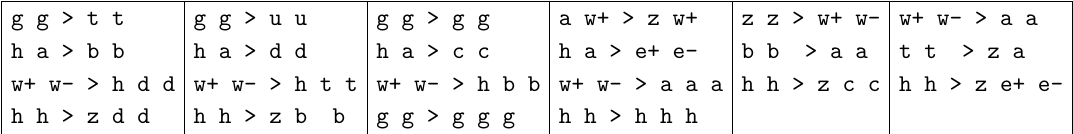
Table 34 . Set of processes that have been used to validate loop-induced SM Higgs couplings implemented in the UFO